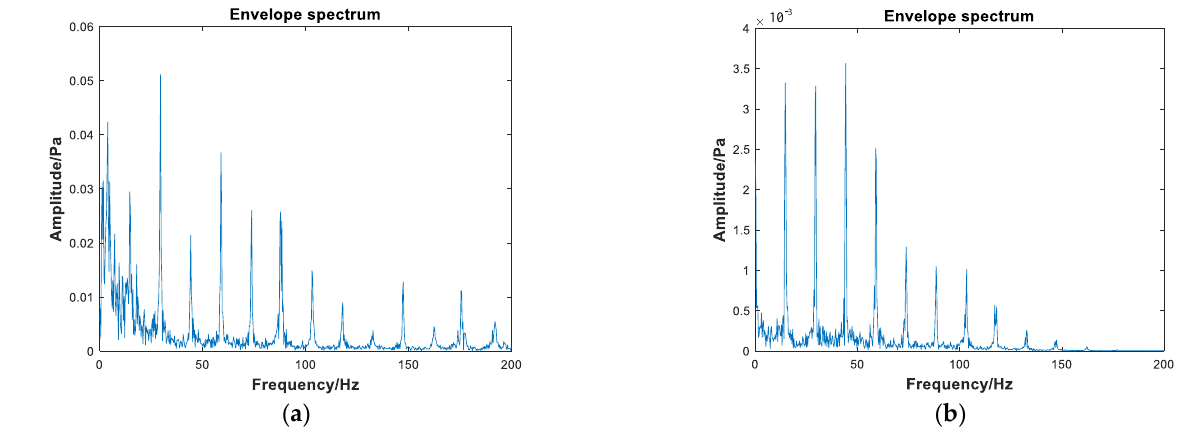
Figure 11. ( a ) Envelope spectrum of the Robinson R44 helicopter before filtering at 1.548 km; ( b ) Envelope spectrum of the Robinson R44 helicopter after filtering at 1.548 km.